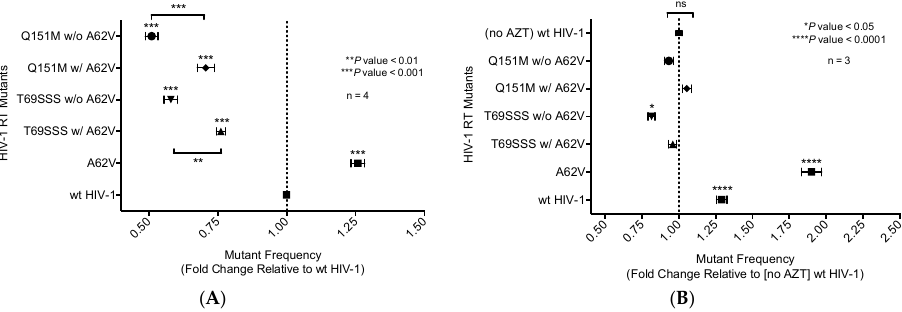
Figure 2. Mutant frequency analysis of multi-drug-resistant HIV-1 mutants in the presence or absence of A62V. Mutant frequency analysis was performed using the pNL4-3 MIG vector by infecting permissive target cells prior to analyzing for expression of a pair of marker genes (mCherry and EGFP) by flow cytometry. Mutant frequencies were calculated by dividing the sum of the number of cells in the single-positive populations (i.e., mCherry + , EGFP − and mCherry − , EGFP + ) by the total number of infected cells. The mutant frequencies were then set relative to the no-AZT wt virus for each experimental replicate. The A62V mutation in HIV-1 RT was analyzed alone or in the presence or absence of the multi-dideoxynucleoside resistant (MDR) Q151M complex (i.e., A62V, V75I, F77L, F116Y, and Q151M) and the T69SSS insertion complex (i.e., M41L, A62V, T69SSS, K70R, and T215Y). The mutant frequency of the MDR mutants, in the absence of AZT ( A ) or in the presence of AZT ( B ). The standard error of the mean (SEM) is represented by error bars. * p -value < 0.05; ** p -value < 0.01; *** p -value < 0.001; **** p -value < 0.0001. Lack of statistical significance is denoted by ‘ns’.